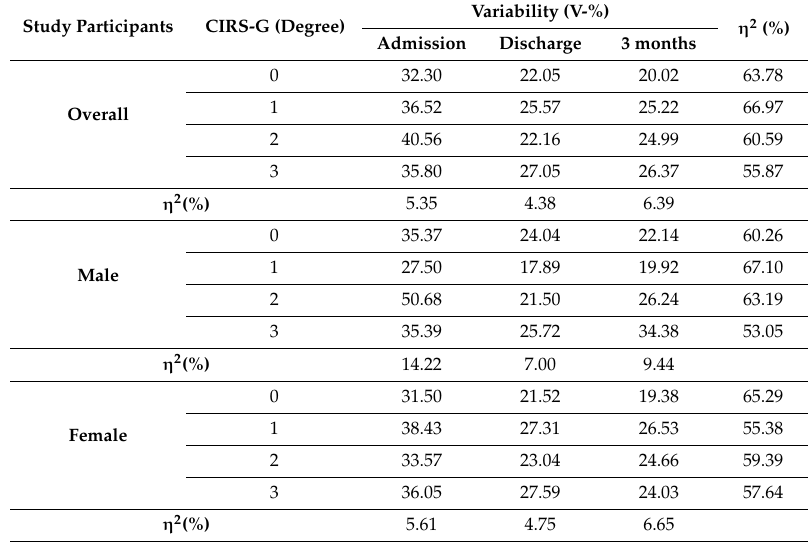
Table 3. Relative variability and e ff ect sizes of evaluated parameters in study